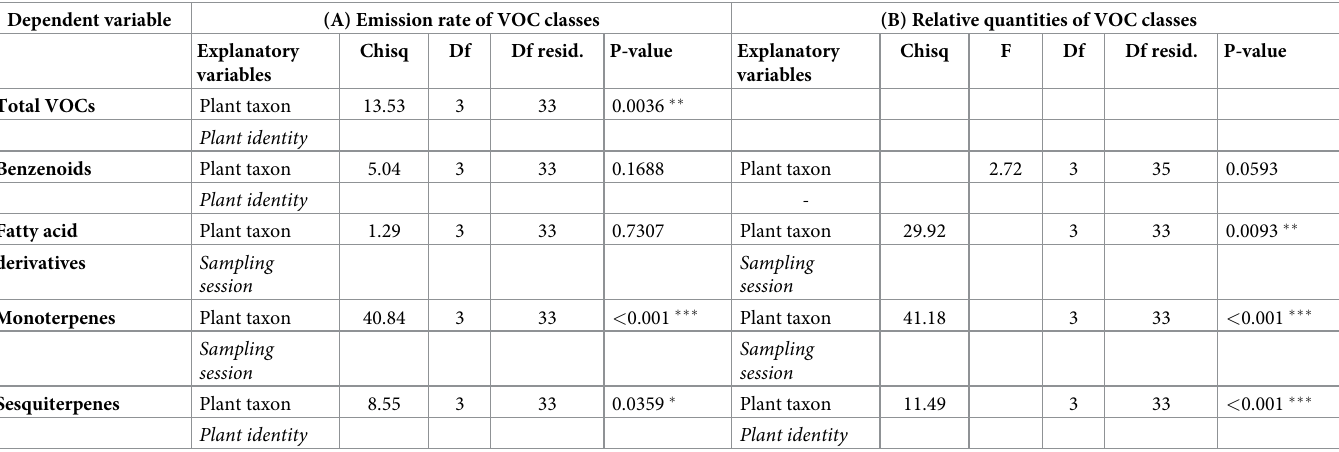
Table 2. Interspecific differences in odour